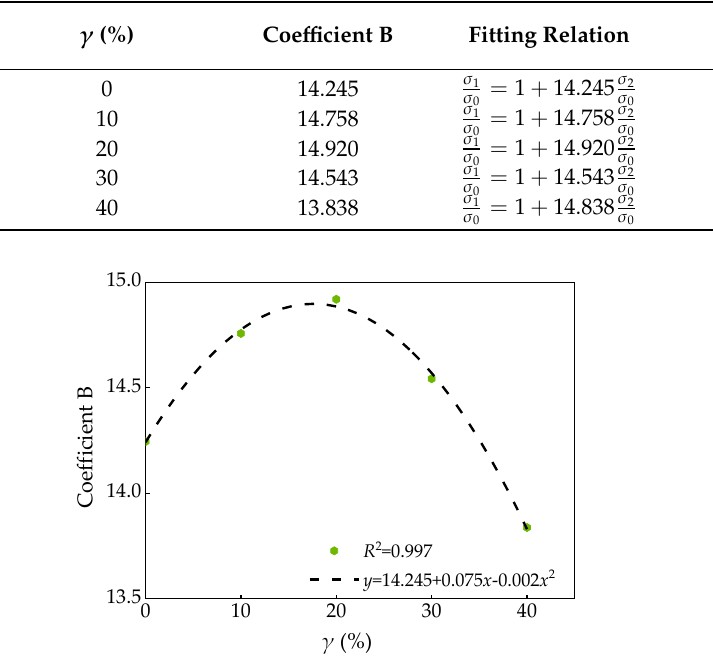
Figure 17. Relationship between coefficient B and FA substitution rate γ .